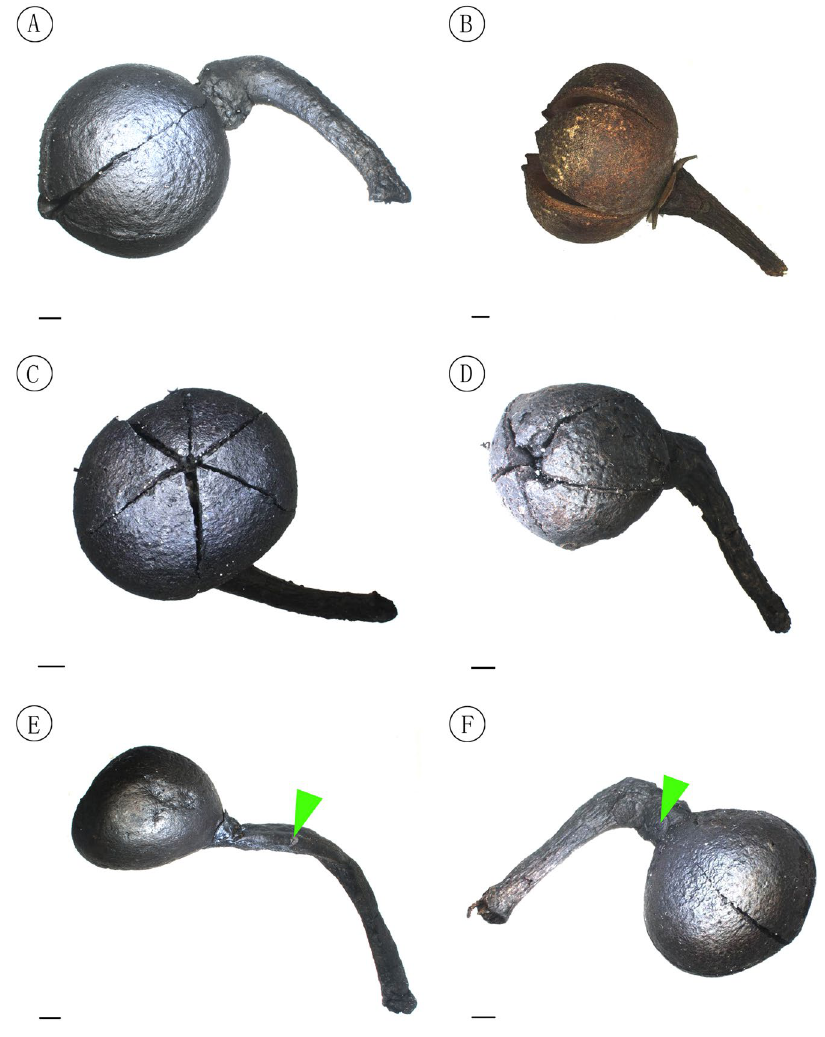
Figure 3. Fruits with pedicels of Schima kwangsiensis sp. nov. and extant Schima superba . ( A ) The fossil fruit showing the globose capsule, and the apically thickened and recurved pedicel (holotype, specimen number NNF-070). ( B ) A modern fruit of the species Schima supberba , collected from the Heishiding Nature Reserve, Guangdong Province. ( C ) The top surface of A showing six loculicidally dehiscent capsule. ( D ) Five loculicidally dehiscent capsules, paratype, specimen number NNF-074. ( E ) A capsule and its long pedicel with bracteole scar (green arrowhead), paratype, specimen number NNF-075. ( F ) Dehiscent capsule showing semiorbicular sepals (green arrowhead), paratype, specimen number NNF-073. Scale bar = 2 mm. Processed and drawn by X. G. Shi using Adobe Photoshop